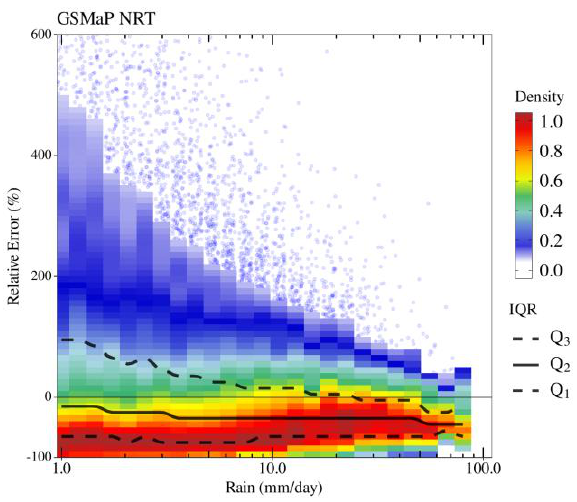
Figure 3. The relative difference distribution between satellite (GSMaP NRT) and ground-based data ( y -axis, in %) as a function of the daily precipitation ( x -axis, in mm day −1 ) over Brazil (land only) for December-January-February-March of three consecutive years (May 2014, June 2015 and July 2016). Panel shows the density scatterplot (colored scale) superimposed by the log-binned IQR distributions (in black) of the relative error vs. the daily accumulated precipitation (log-scale distributed). Outliers are represented by blue dots.